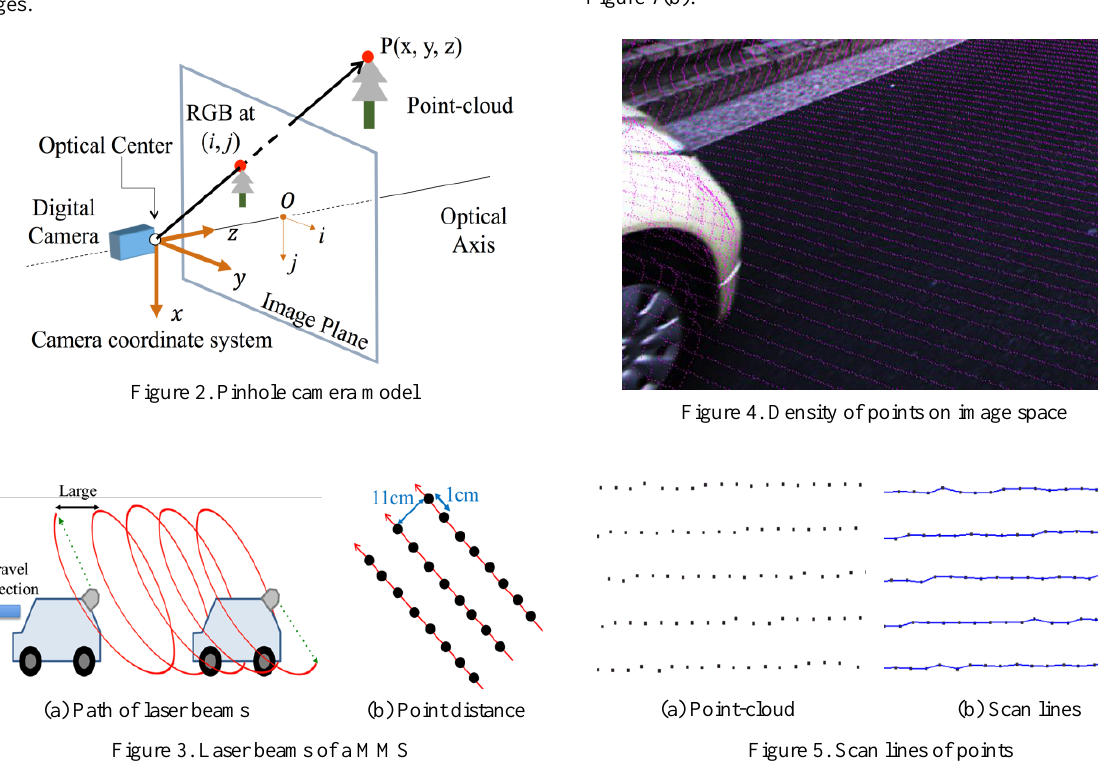
Figure 3. Laser beams of a MMS